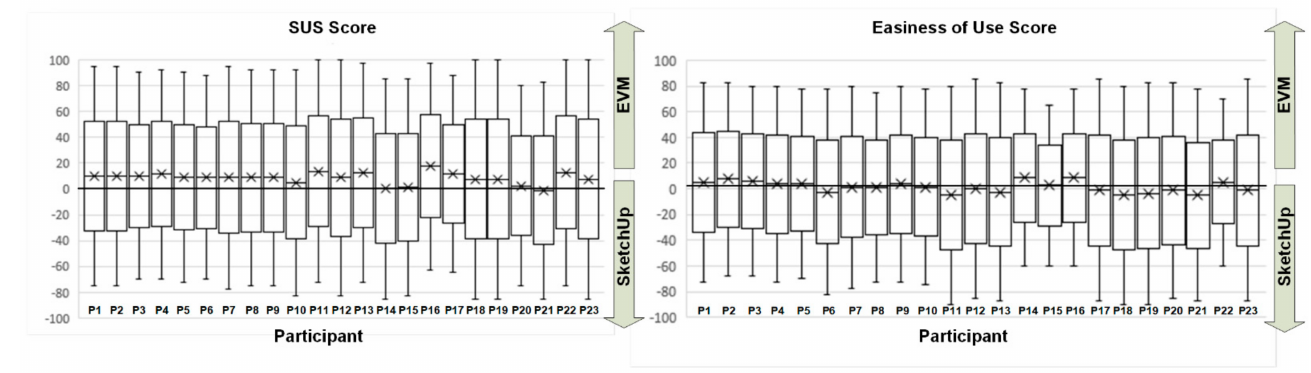
Figure 11. Relative SUS and ease of use scores per